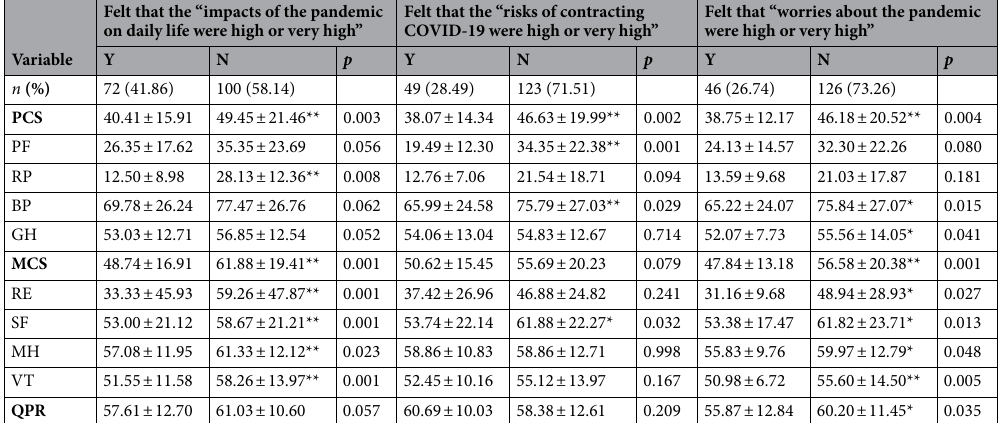
Table 2. Comparisons of PCS, MCS and QPR during the COVID-19 pandemic by thoughts about the pandemic (M ± SD, n = 172). * p < 0.05, ** p < 0.01.